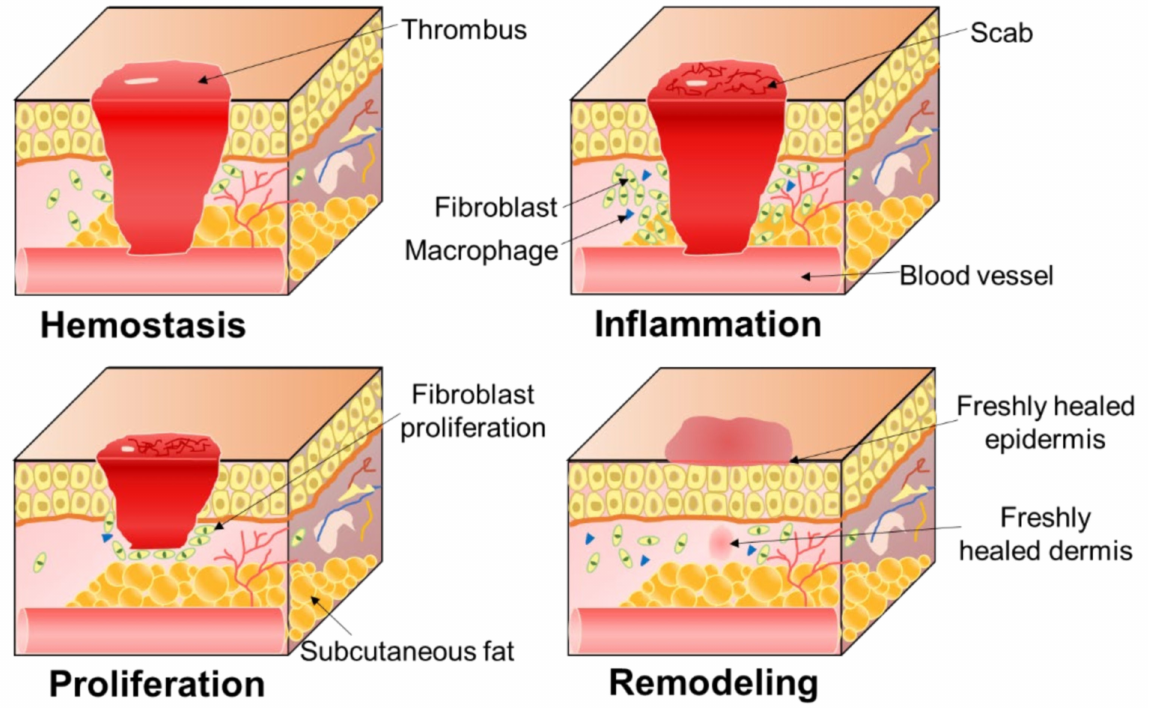
Figure 2. Wound healing